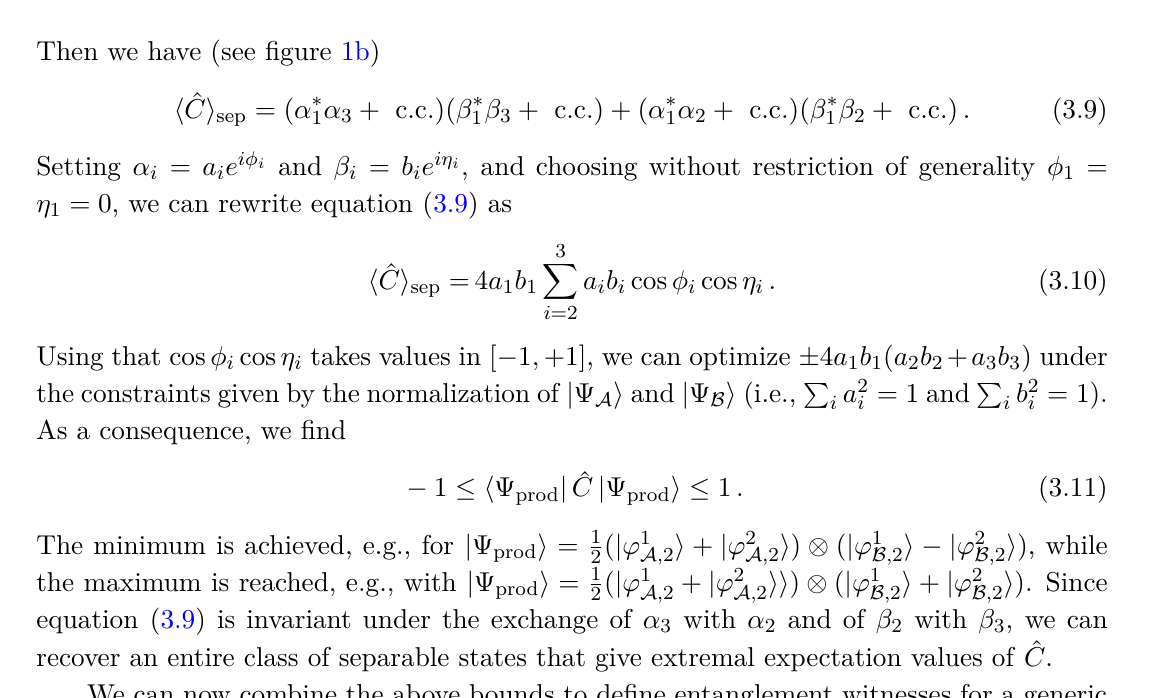
Figure 2. (a) Example geometry and SS considered in section 3, with N = 2 plaquettes in both subregions A and B . (b) Constituents from which the entangled state | ξ i of the pure-gauge U(1) theory is constructed and action of the plaquette-operator components of the operator ˆ C defined in eq. (3.7). (c) After tracing out the region neither in A nor B (i.e., the two central bonds in panel a), one obtains two pairs of allowed SSs. Top: H A ( Z A , 1 ) ⊗ H B ( Z B , 1 ) . Bottom: H A ( Z A , 2 ) ⊗ H B ( Z B , 2 ) . (d) Basis states associated with H A ( Z A , 1 ) (top left, red), H B ( Z B , 1 ) (top right, blue), H A ( Z A , 2 ) (bottom left, red), and H B ( Z B , 2 ) (bottom right,